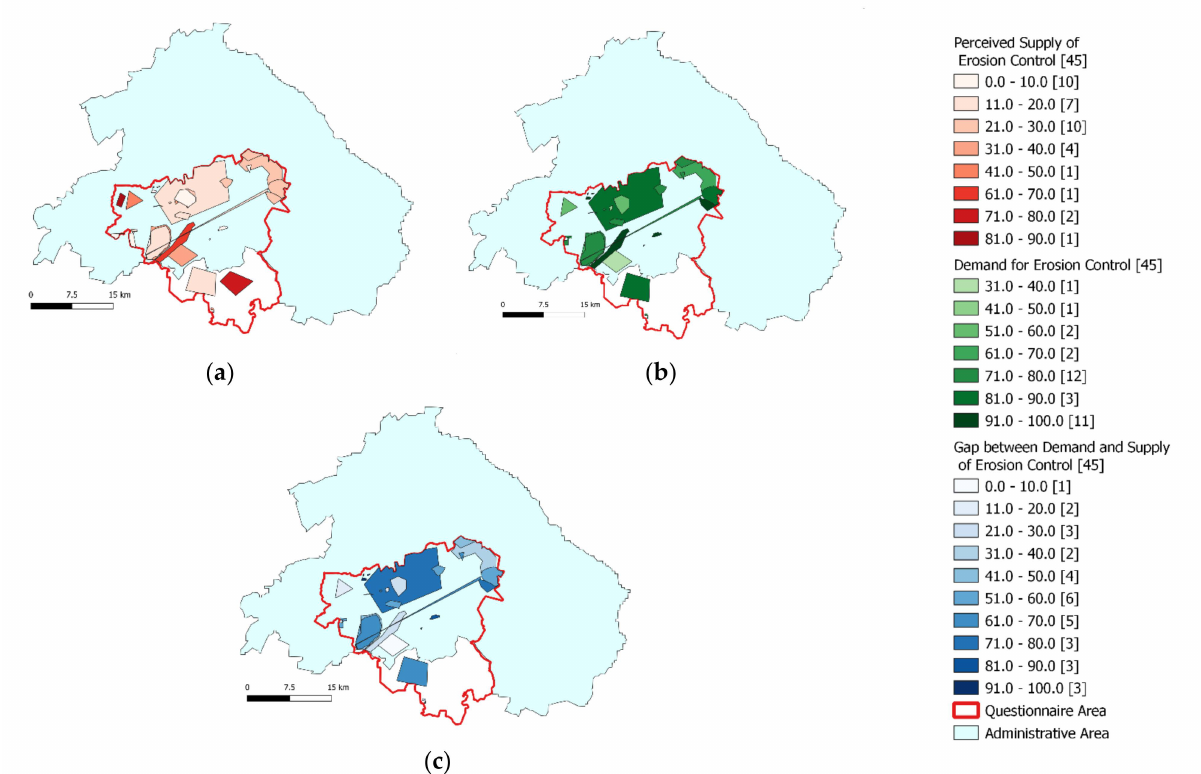
Figure 5. Supply perceived ( a ), demand stated ( b ) and the gap ( c ) for erosion control in